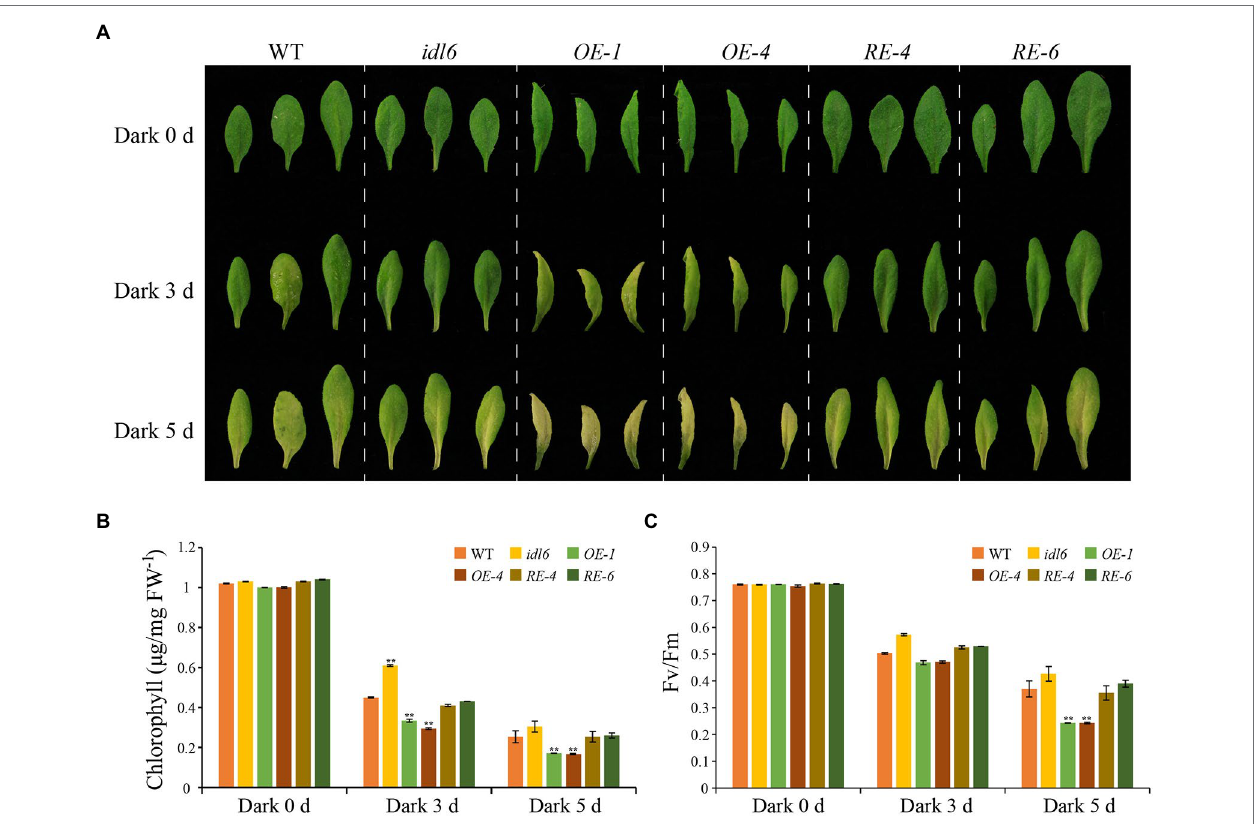
FIGURE 8 | Dark-induced senescence in detached leaves with altered IDL6 expression. (A) The senescence phenotype s of the 5th, 6th, and 7th leaves from 4.5-week-old plants under dark treatment. Chlorophyll contents (B) and photosynthetic efficiency (C) of each leaf were measured after dark treatment for 0, 3 and 5 days. Error bars showed the SE ( n = 3). Significant differences (** p < 0.01) compared with the wild type in each group were determined by Student’s t -test. Three independent experiments were carried out with similar